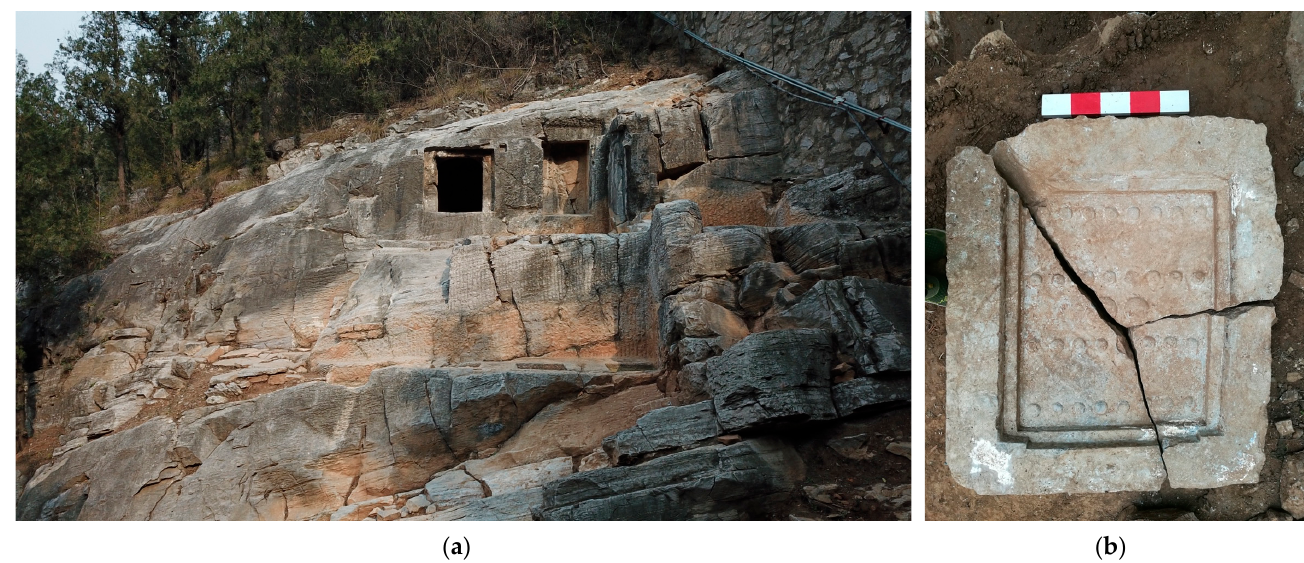
Figure 1. ( a ) Wanfogou Cave 1 (left) with its attached niche (right); ( b ) the restored “stone gate” that had fallen in front of Wanfogou Cave 1. Photos by Li Lan,